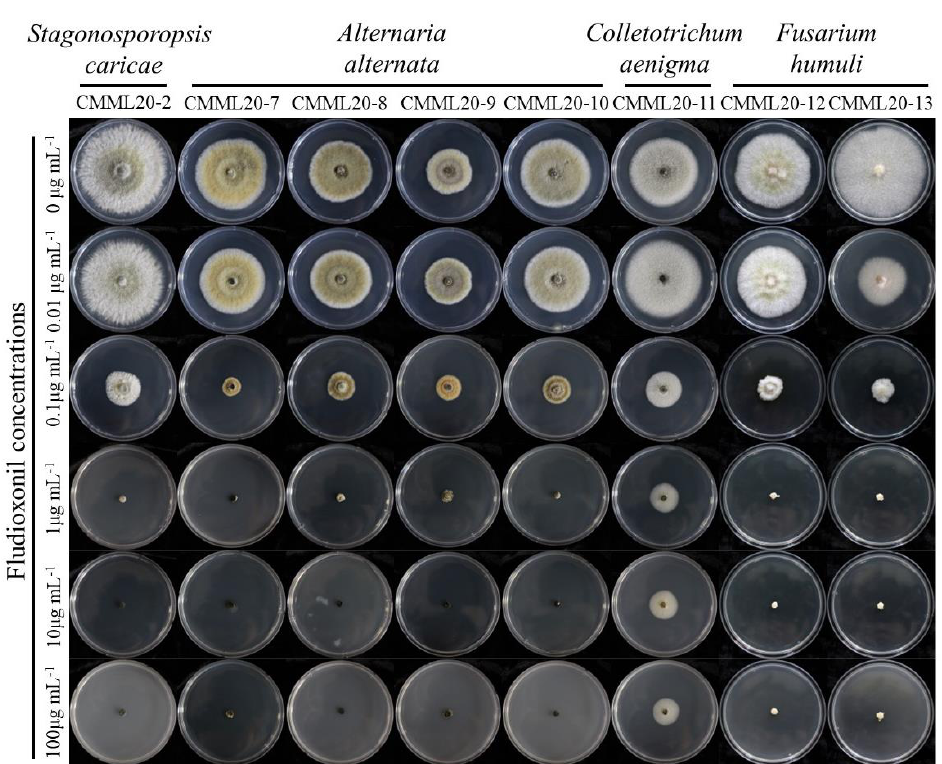
Figure 8. Anterior view of colonies of all fungal isolates on non-supplemented PDA and supple- mented with 0.01, 0.1, 1, 10, or 100 μg mL − 1 of metconazole.